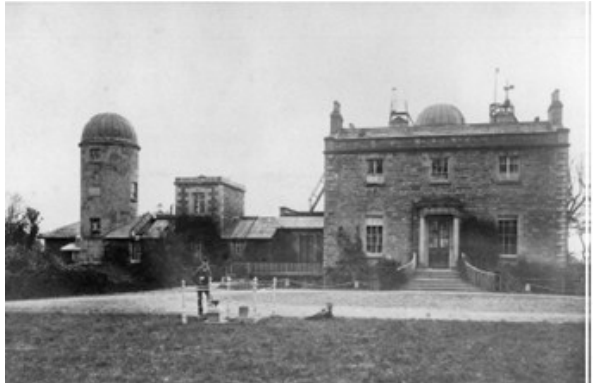
Figure 1: Armagh Observatory